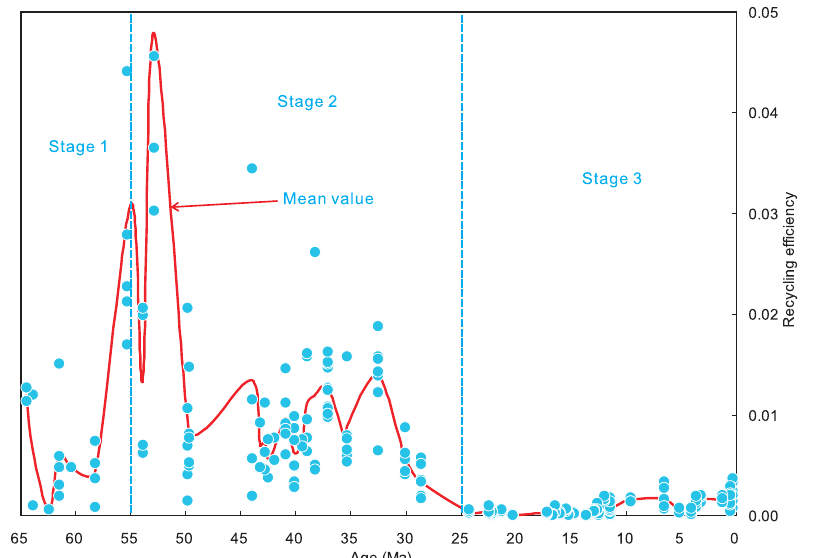
Fig. 4 Three-stage evolution of recycling ef fi ciency. Each fi lled blue dot denotes a calculation result of the recycling ef fi ciency by CCFM based on a set of geochemical data (including major element, trace element and Sr – Nd – Pb isotope composition) of each sample from 287 samples (for detailed calculation procedures see Supplementary Data 2 and “ Methods ” ), which have been distributed in 55 volcanic fi elds in Tibetan Plateau in the Cenozoic (Fig. 1). The mean value of the recycling ef fi ciencies in each volcanic fi eld is shown as a solid red curve (for detailed calculation results of the mean values see Table